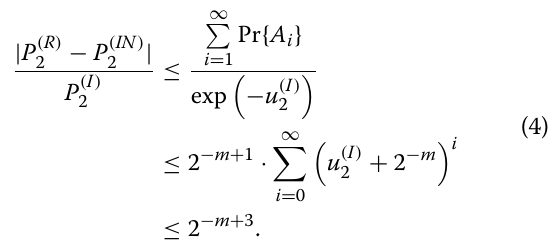
Isochronous exponential Bernoulli sampling